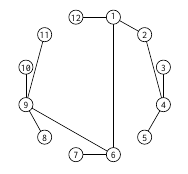
Fig. 1: A non-crossing tree of size